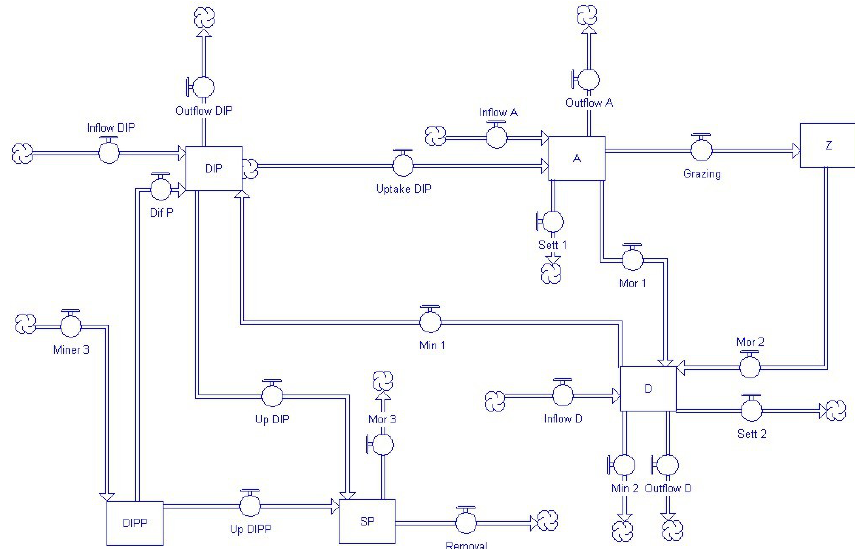
Figure 3. Conceptual diagram of each compartment model.